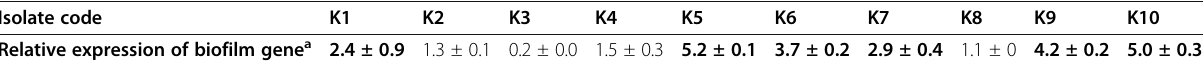
Table 2 The relative gene expression (mean ± SD) of the tested K. pneumoniae isolates after repeated exposure to sublethal concentrations of BAC Isolate code